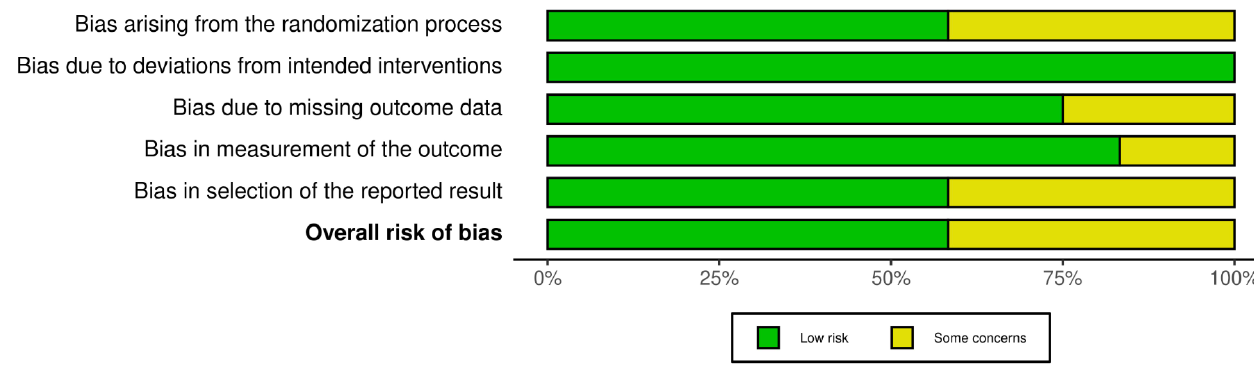
Figure 3. Risk of bias summary.